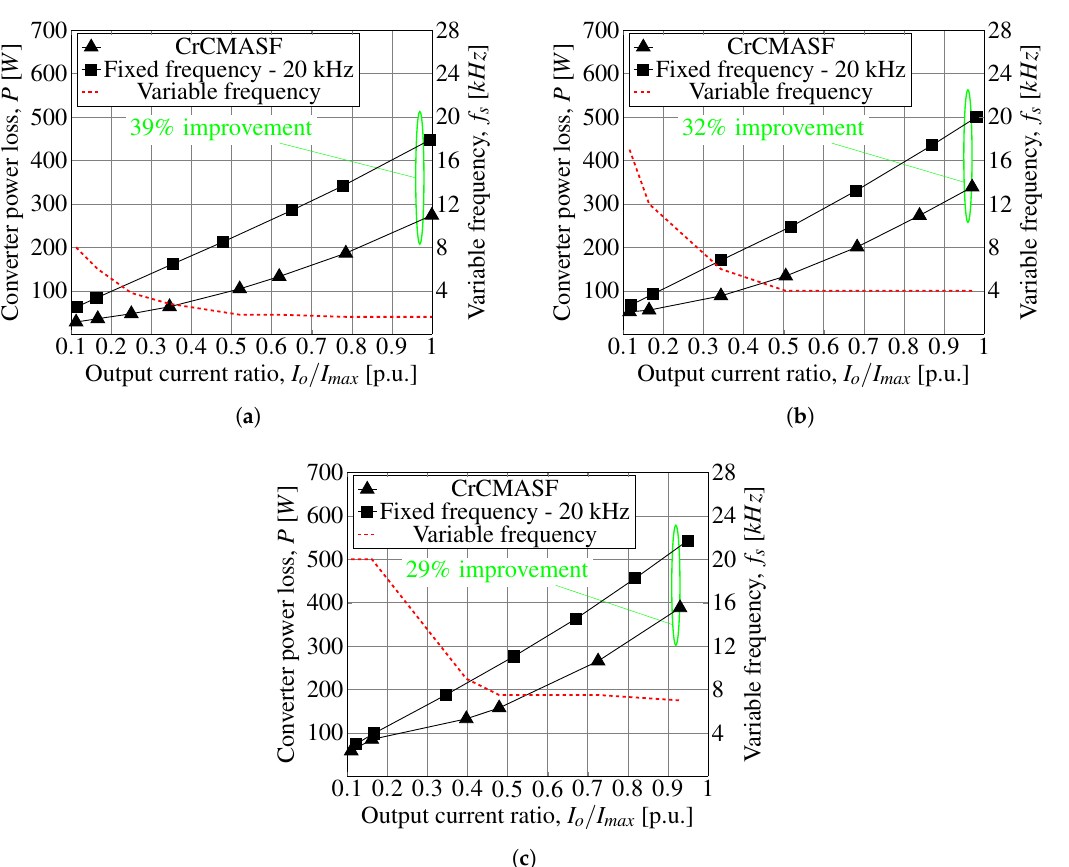
Figure 14. Measured converter losses for different duty cycles for switch 1: ( a ) converter losses for a duty cycle of 0.95; ( b ) converter losses for a duty cycle of 0.9; ( c ) converter losses for a duty cycle of